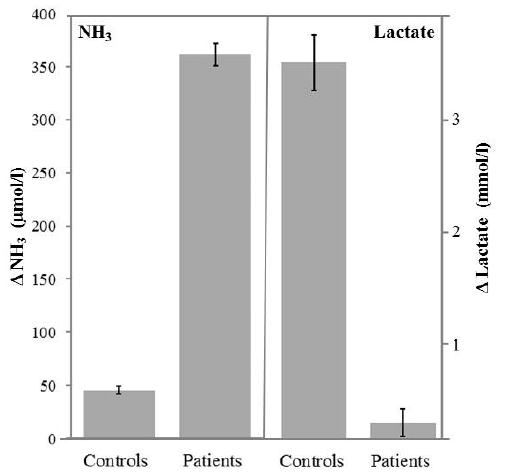
Figure 1. Forearm lactate ischemic test showing significantly higher ( p < 0.001) ammonia production but significantly lower ( p < 0.001) lactate production upon exercise in patients with McArdle disease ( n = 16) compared to healthy controls ( n = 21). The bar charts represent mean values of delta ammonia and delta lactate in patients and healthy controls respectively. The error bars represent standard